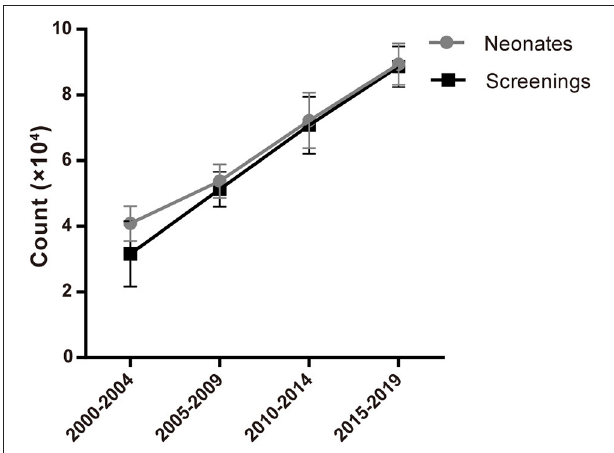
FIGURE 2 | Number of neonates and screenings from 2000 to 2019.